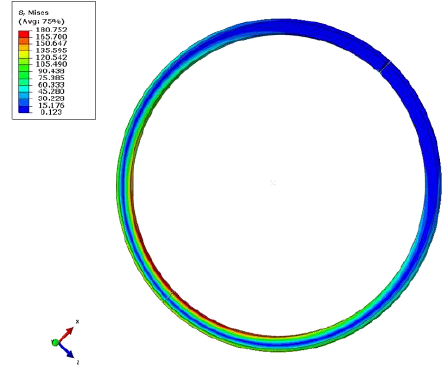
Fig. 5. View of the state of stress in the compression ring engine EMD645